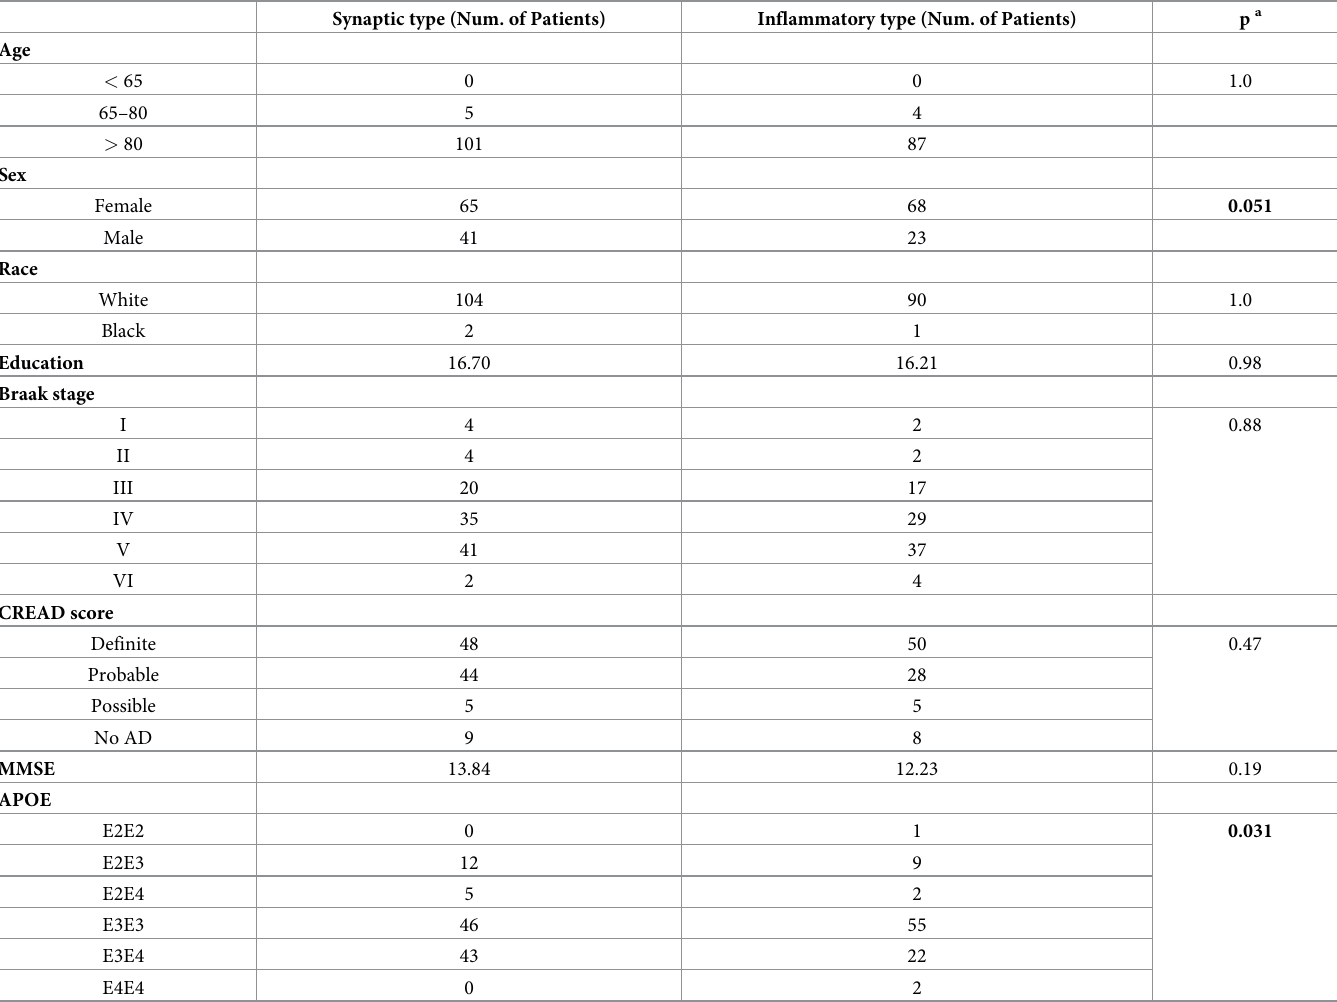
Table 3. Association of AD molecular subtype with demographic, clinical variables and APOE genotype in the ROSMAP dataset. Synaptic type (Num. of